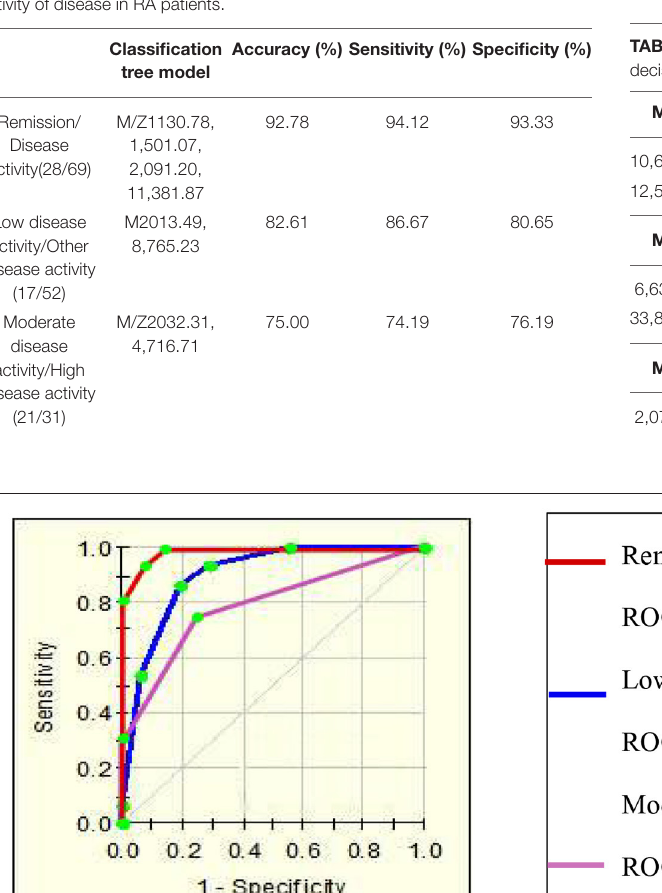
TABLE 5 | Establishment of the classification tree models for assessing the activity of disease in RA patients.